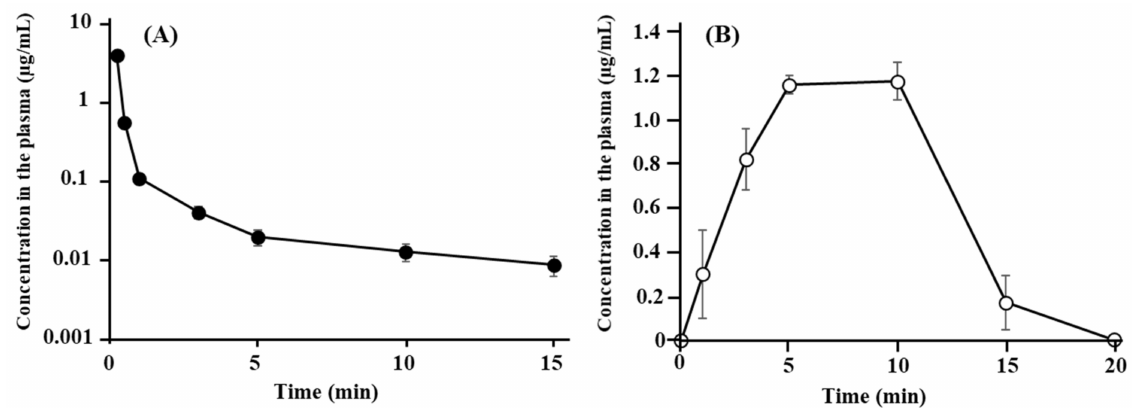
Figure 1. Concentration profiles of ANA-TA9 in the plasma after ( A ) bolus intravenous injection and ( B ) constant intravenous infusion. Keys: ● : bolus intravenous injection and ￮ : constant intravenous infusion. The results are expressed as the mean ± SE of three experiments.